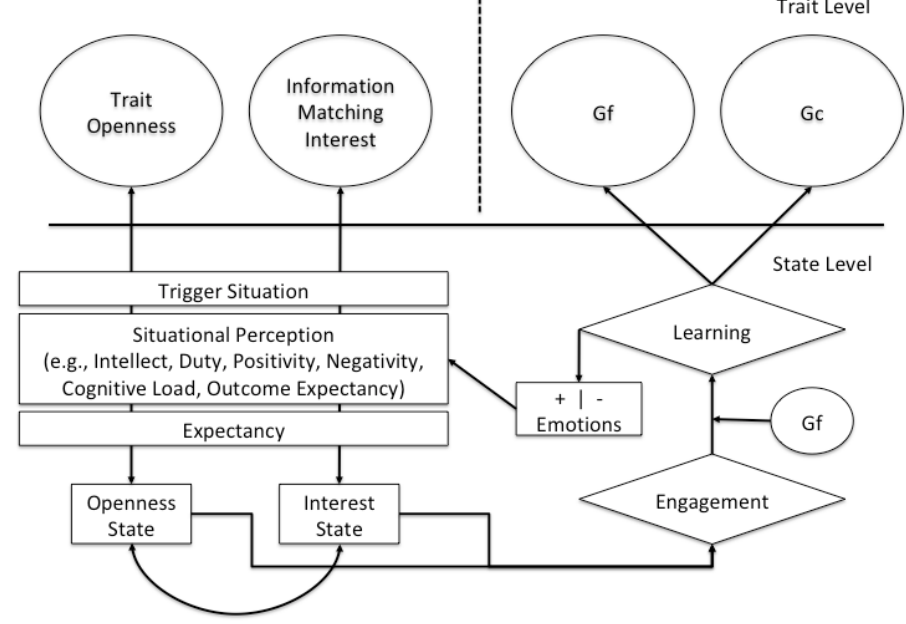
Figure 2 . Adaptation of the TESSERA model [4] to the environmental enrichment path of the OFCI model. The dotted line reflects a difference in time. Manifest variables are depicted by rectangles and latent variables by circles.